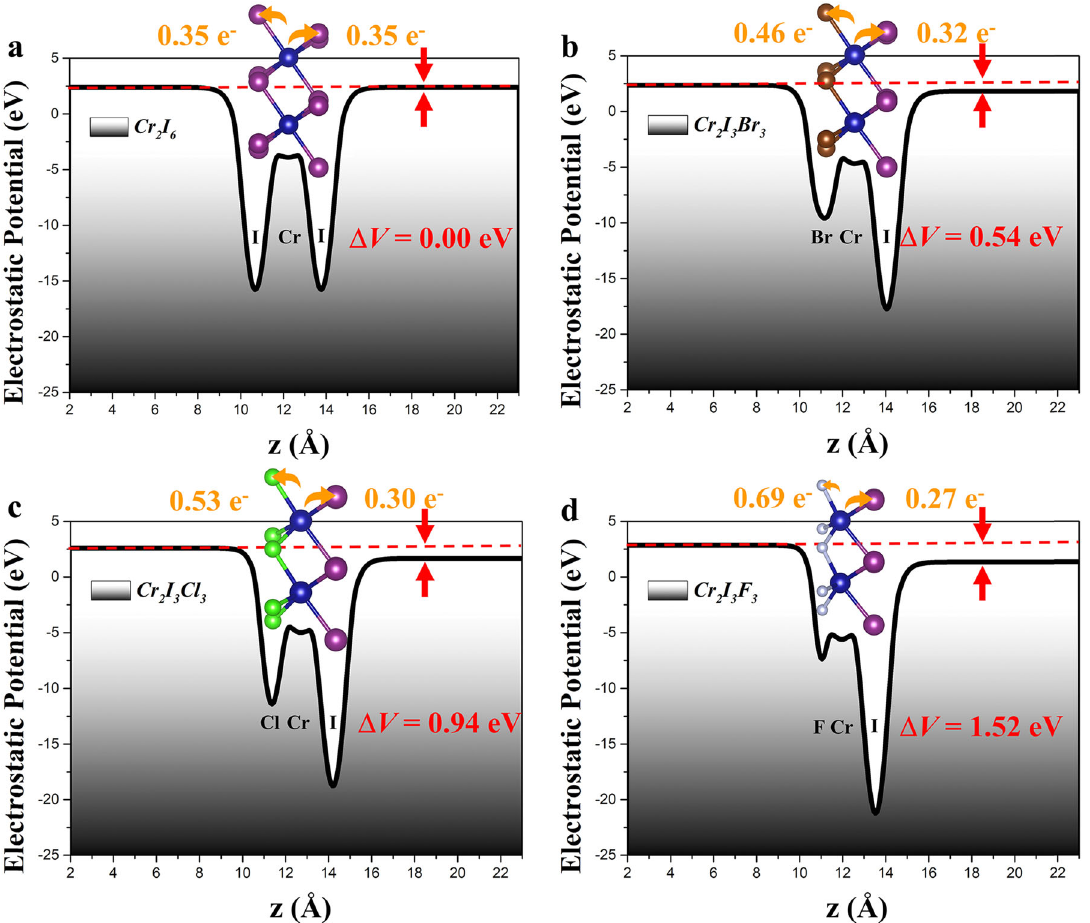
Fig. 4 The electrostatic potential and the charge redistribution. a , d The electrostatic potential of ( a ) Cr 2 I 6 , ( b ) Cr 2 I 3 Br 3 , ( c ) CrI 3 Cl 3 and ( d ) Cr 2 I 3 F 3 monolayer. The side views of corresponding structures are inserted in accordance with electrostatic potentials. The electrostatic potential difference Δ V between the upper and lower halogen elements are indicated in red arrows between the dotted extension line and black line of vacuum level, speci fi c values are listed in red as well. Orange arrows and numbers represent the charge redistribution from Cr atom to the surface atom. Cr 2 I 3 F 3 , respectively. The sign and value of fi nal MAE are mainly determined by the contributions of halogen- p orbitals. For Cr 2 I 6 and Cr 2 I 3 Br 3 , the net contribution of I- p and Br- p atoms to MAE is positive, indicating that the easy-axis for Cr 2 I 6 and Cr 2 I 3 Br 3 monolayer is the z -axis. For Cr 2 I 3 Cl 3 , the negative contribution of I- p as shown in Fig. 5h can counteract the positive contribution of Cl- p as shown in Fig. 5i, which thoroughly leads to a net negative MAE of − 1.23 m eV/unit cell with x -axis as an easy axis. For Cr 2 I 3 F 3 , the MAE is mainly dominated by I- p orbitals with hybridization between p x and p y , and the contributions of Cr- d and F- p orbitals are tiny, which leads to a net negative MAE of − 10.45 m eV/unit cell with x -axis as an easy axis. That is to say that the vibration of MAE is dominated by halogen atoms instead of transition metal Cr 51 , and the value of Δ E MAE declines from positive to negative with different halogen atoms following the sequence of Cr relationship between MAE and EP, we put emphasis on MAE with arbitrary spin orientations on xz- and yz -plane and the synergetic evolutions of EP as shown in Fig. 6 54 . For comparison, MAE with spin orientations for different angles within yz - and zx -planes for Cr npj 2D Materials and Applications (2022)